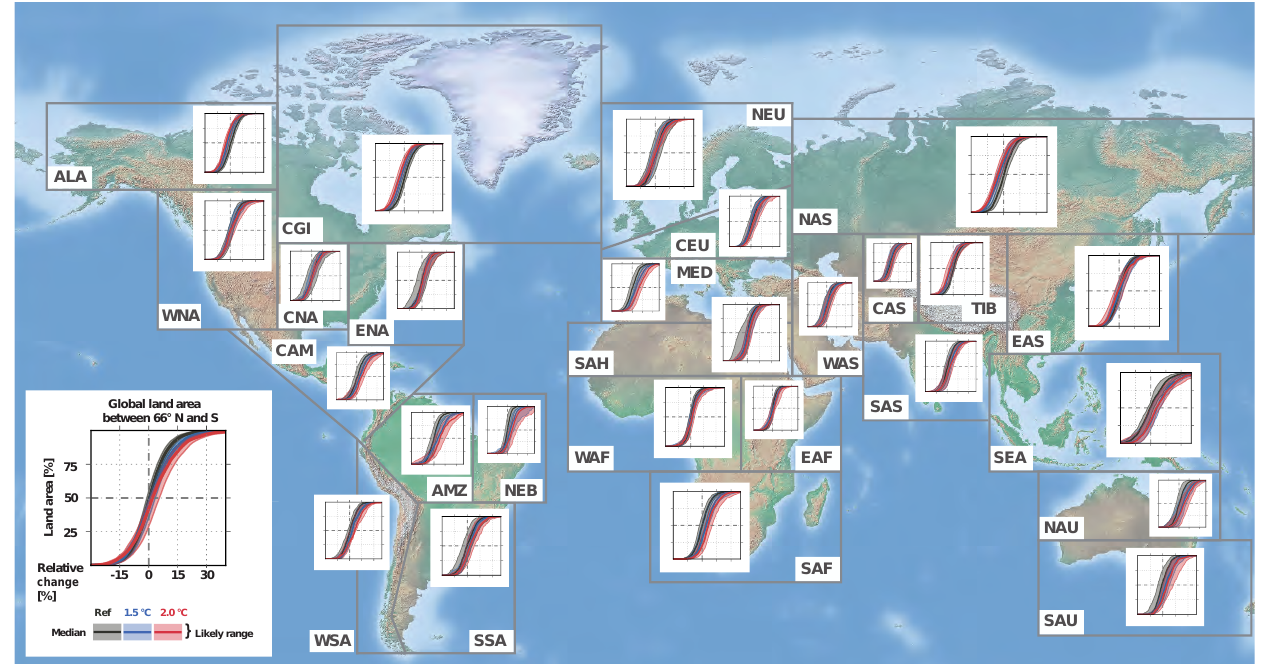
Figure 6. Same as Fig. 2 but for CDD. Changes are given relative to the 1986–2005 reference period.